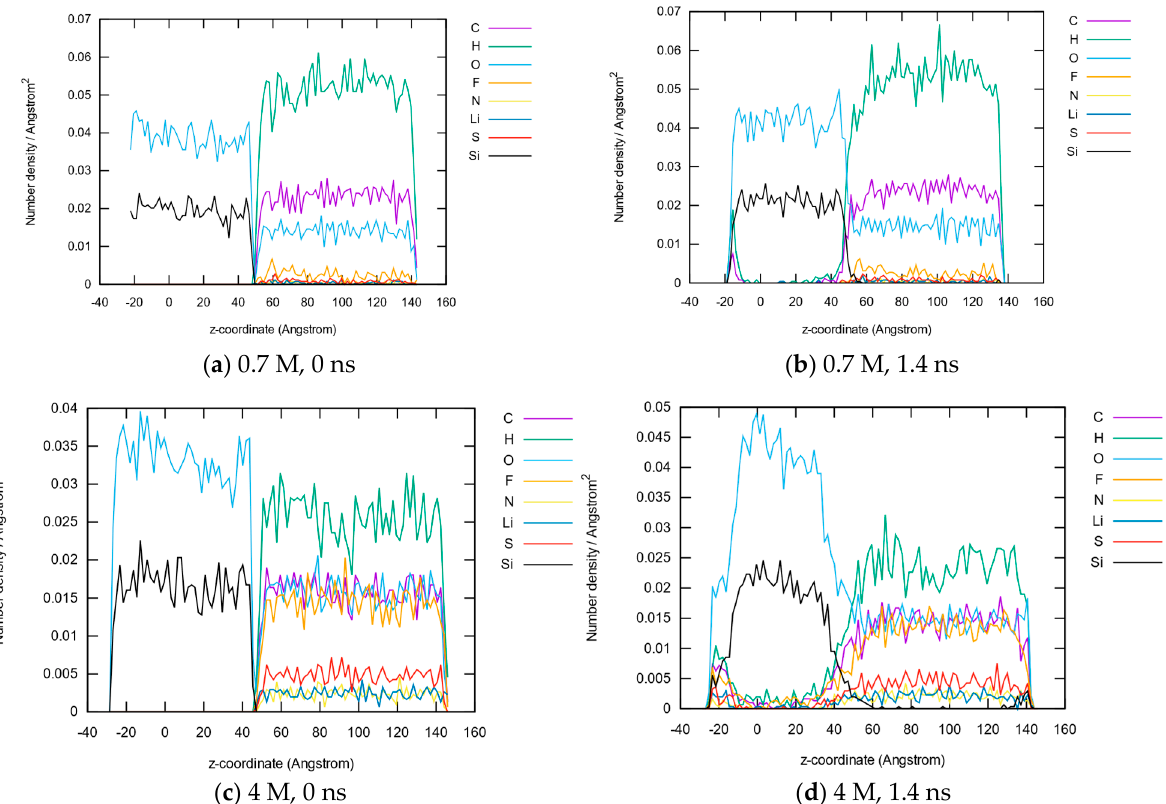
Figure 6. Element concentrations along the z -axis at the first and last timesteps of both simulated electrode – electrolyte interface systems for 0.7 M LiTFSI at 0 ns ( a ) and 1.4 ns ( b ) and 4 M LiTFSI at 0 ns ( c ) and 1.4 ns ( d ).